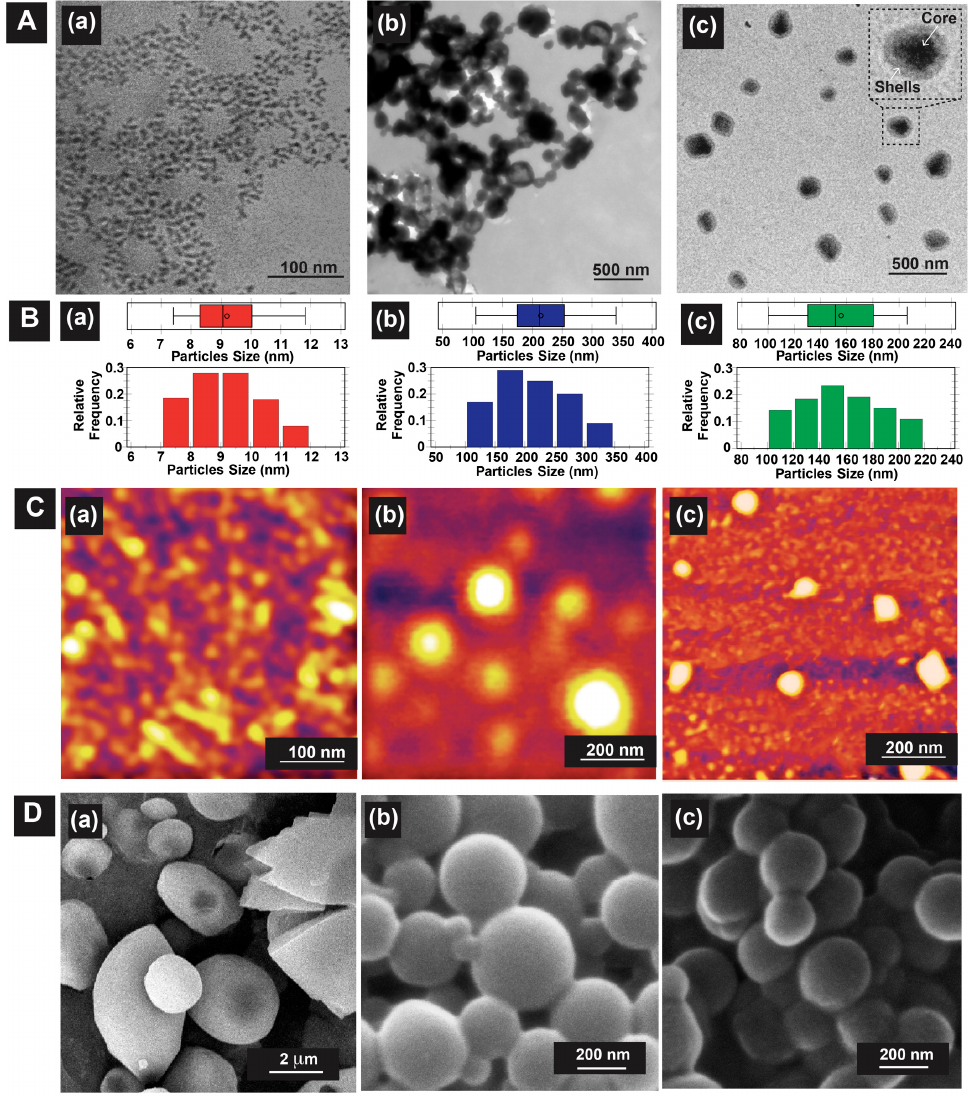
Figure 2. Representative morphological information from ( A ) TEM and ( B ) particle distribution as determined from TEM images, ( C ) AFM, and ( D ) SEM images of ( a ) WCS, ( b ) DC-WCS, and ( c ) DC-WCS-PG (WCS:PEGMA mole ratio = 1:5, co-solvent, 10 kGy, DG = 252%).